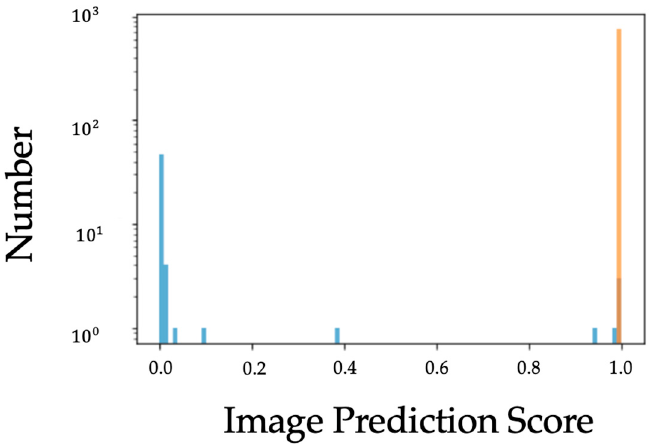
Figure 8. Histogram plot shows predicted DSB non-violent (light blue bars) and violent (orange bars) actions in images classified in the prototype trained with SVD enriched with